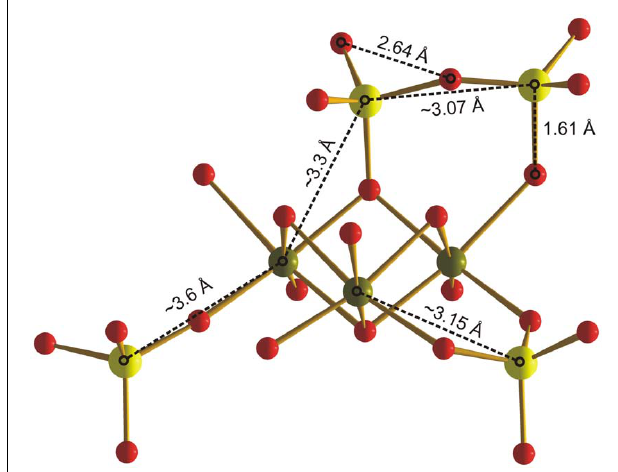
FIGURE 6 | Schematic illustration of three possible silicate surface complexes on an idealized portion of the ferrihydrite structure. Fe(III) (green) is shown in octahedral coordination with O (red). Si (yellow) is tetrahedrally coordinated with O (SiO 4 ). Approximate Si–Fe distances for SiO 4 linked (1) bidentate to two neighboring Fe octahedra via corners ( ∼ 3.15Å), (2) monodentate to a doubly/triply coordinated O ( ∼ 3.3Å), and (3) monodentate to a singly coordinated O ( ∼ 3.6Å). Si ... Si distances ( ∼ 3.07Å) indicate formation of silica polymers, possibly also on the ferrihydrite